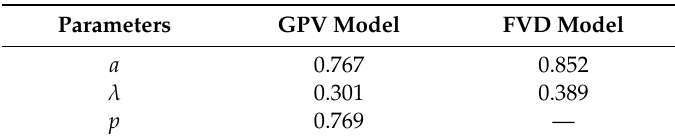
Table 2. Calibration results of parameters in the generalized preceding vehicles (GPV) model and the full velocity difference (FVD) model.